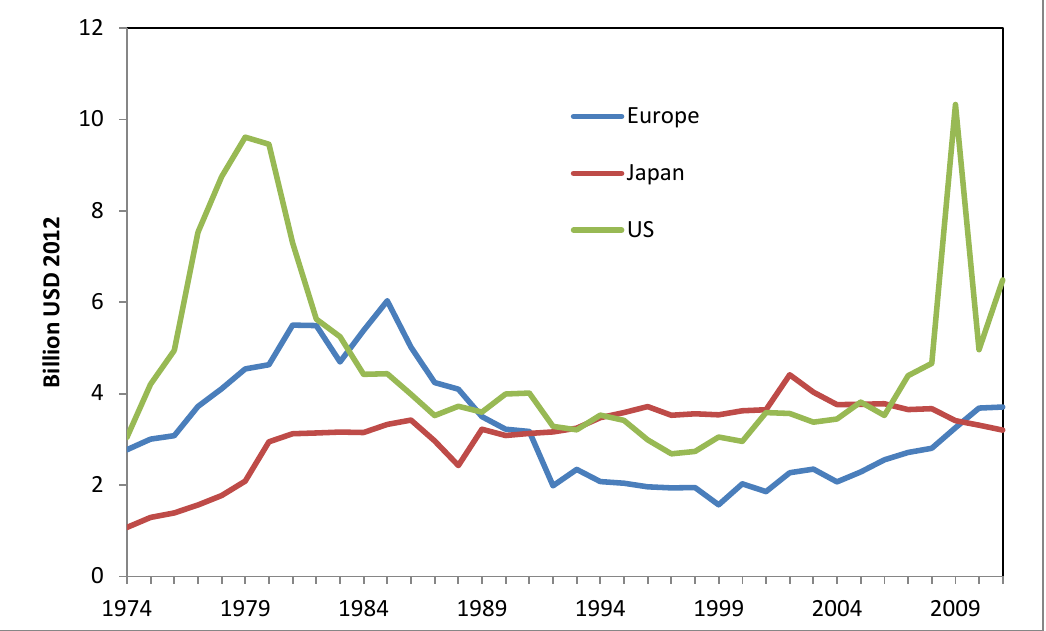
Figure 7. Historic Public Energy RD&D Spend in the US, Japan and major European economies 1974–2011. [3].